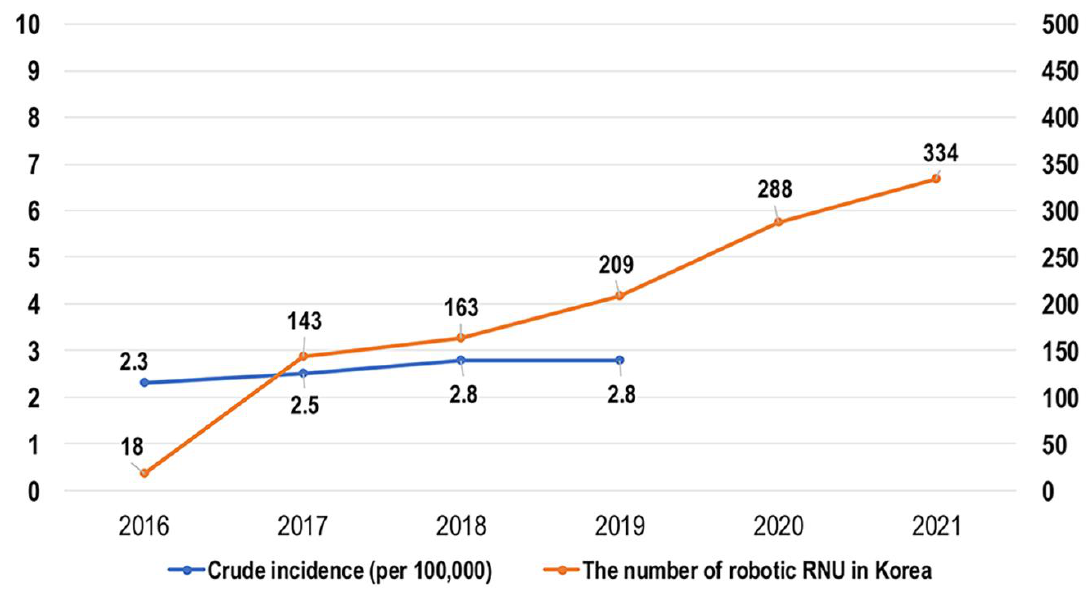
Figure 3. The utilization of robotic radical nephroureterectomy and annual crude incidence rate (per 100,000 persons) of upper tract urothelial carcinoma in Korea. RNU, radical